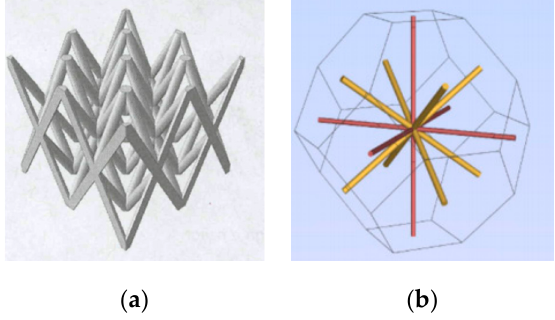
Figure A6. ( a ) Pyramidai cell [148]; ( b ) Kelvin cell [149].